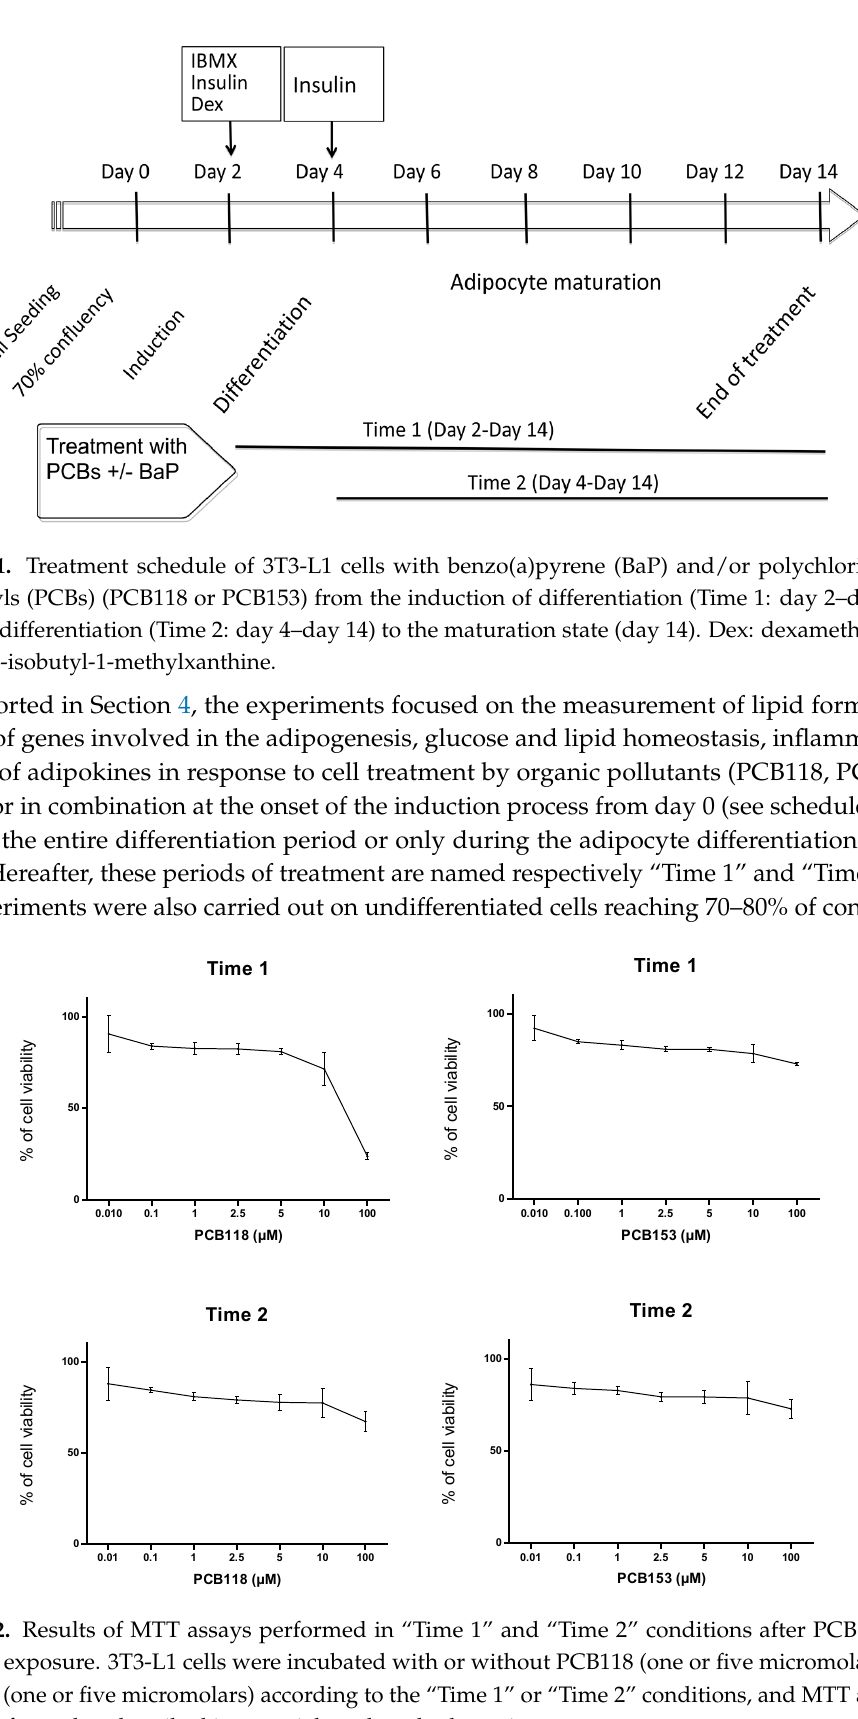
Figure 2. Results of MTT assays performed in “Time 1” and “Time 2” conditions after PCB118 or PCB153 exposure. 3T3-L1 cells were incubated with or without PCB118 (one or five micromolars) or PCB153 (one or five micromolars) according to the “Time 1” or “Time 2” conditions, and MTT assays were performed as described in materials and methods section.